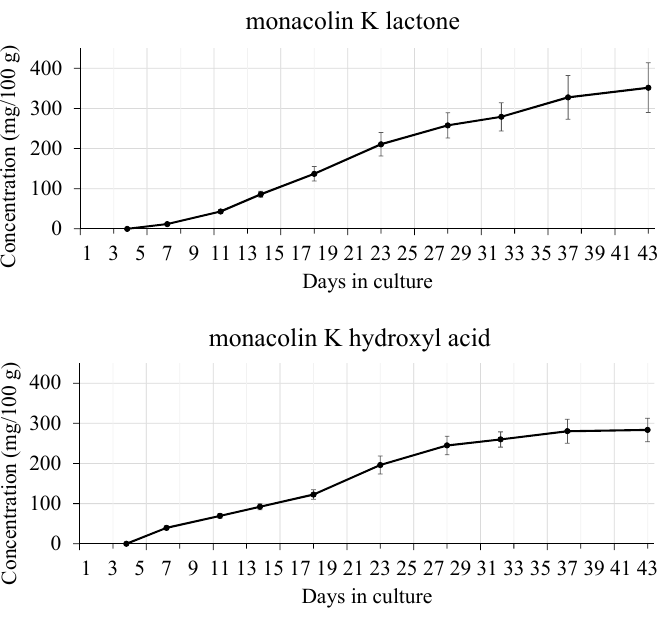
Figure 9. Time course change in the content of lactone form and acid form of monacolin K in red yeast rice during fermentation, quantified using the method specified by the Korea Food and Drug Administration (KFDA) [29].